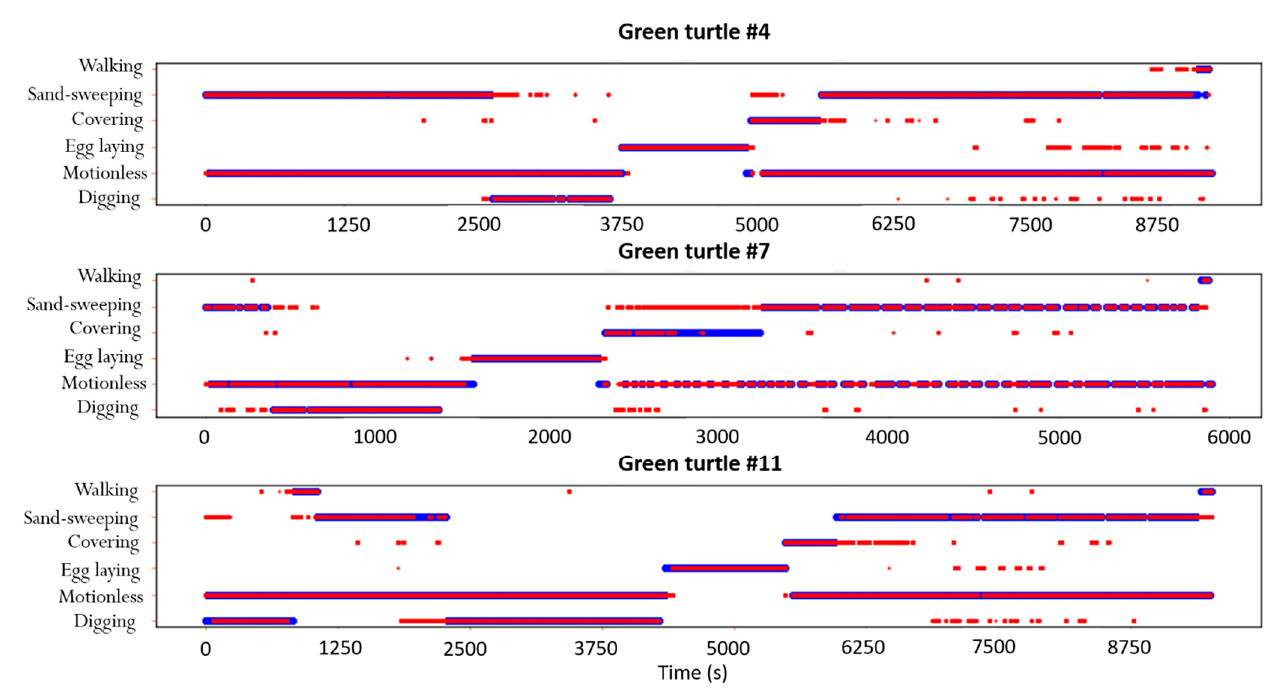
Figure 6. Activity budget of the three green turtles of the validation dataset showing the behaviors inferred by the V-net (in red) compared to actual behaviors (in blue). Table 3. Estimations of the number of laid eggs for eight green turtles from the Egg laying period identified by the V-net and/or manually extracted from the acceleration visualization compared to the actual observed numbers on the field.